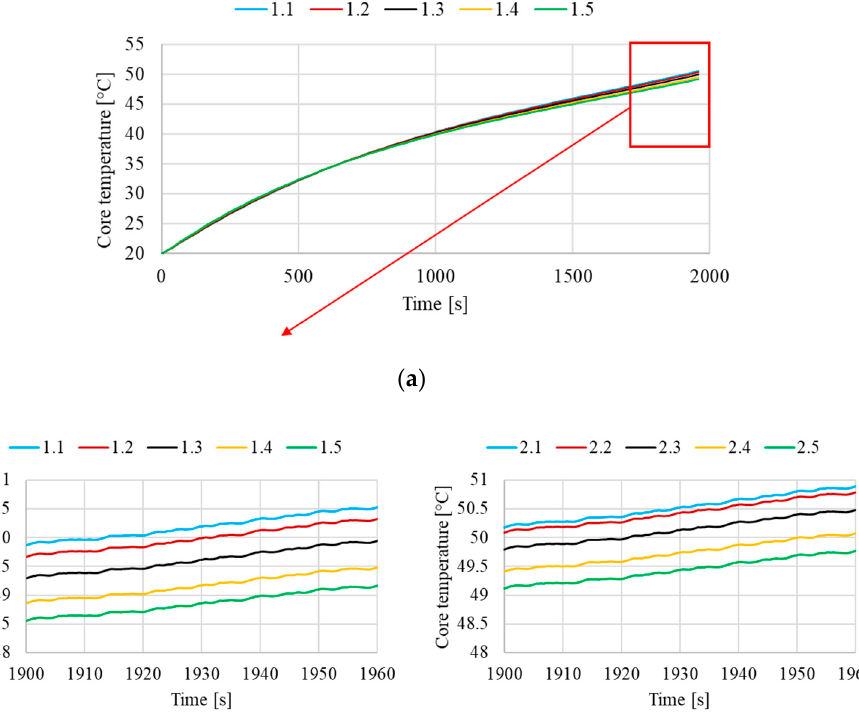
Figure 13. Heat transfer coefficient variation with air flow obtained from CFD simulations. Using these 3D heat transfer maps (h = f(Q cell , V ̇ air )) , the maximum temperature in the analyzed battery segment, the maximum temperature difference in the segment and the maximum temperature difference in a single accumulator are evaluated at the end of the endurance race, and the results are illustrated in Figure 14.